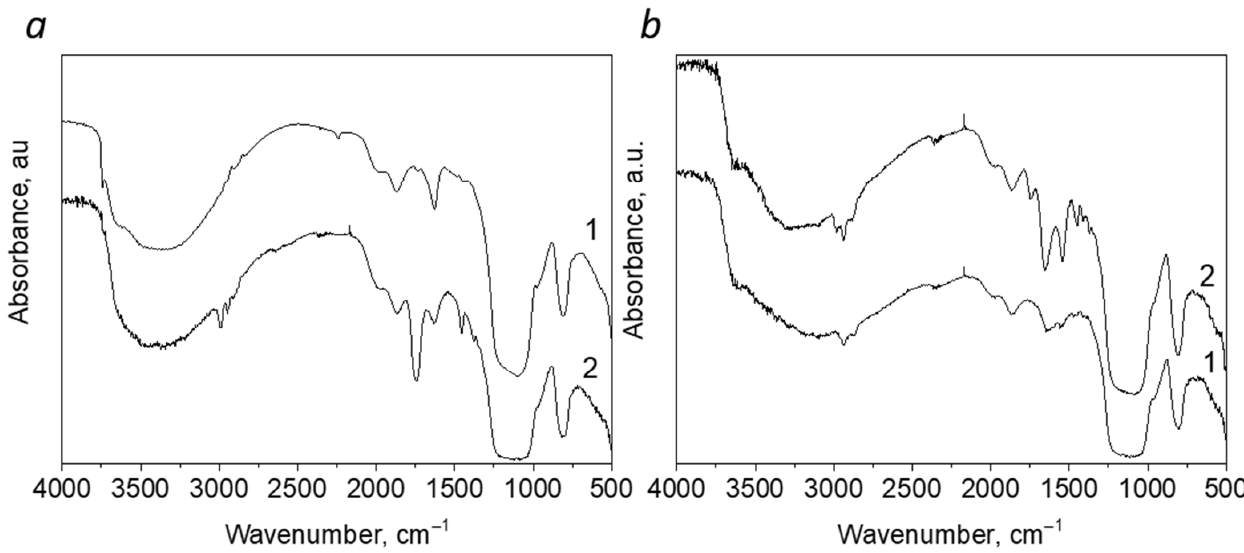
Figure 3. IR spectra of ( a ): Silochrom (1), composite Silochrom/PLA (2); ( b ): Silochrom ‐ NH 2 (1), composite Silochrom ‐ NH 2 /PLA (2).